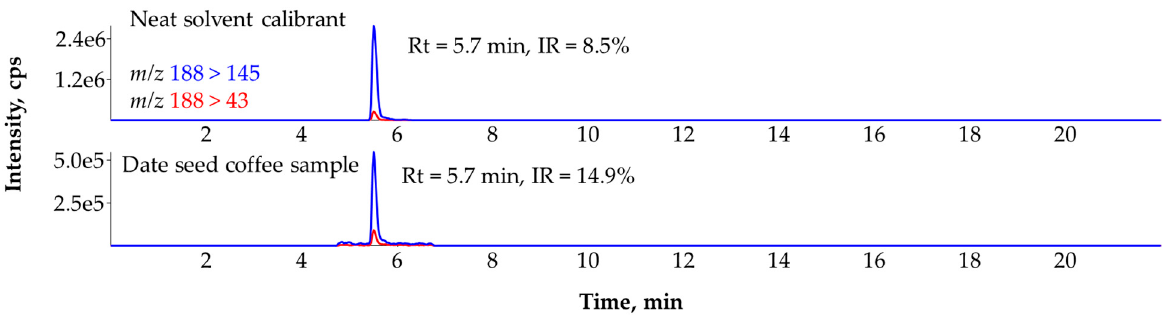
Figure 1. Screening analysis of a date seed coffee sample. The IR (8.5%) of ion transitions of atrazine- desethyl in a neat solvent calibrant (100 ng/mL, above) excluded the presence of it in the sample (below).